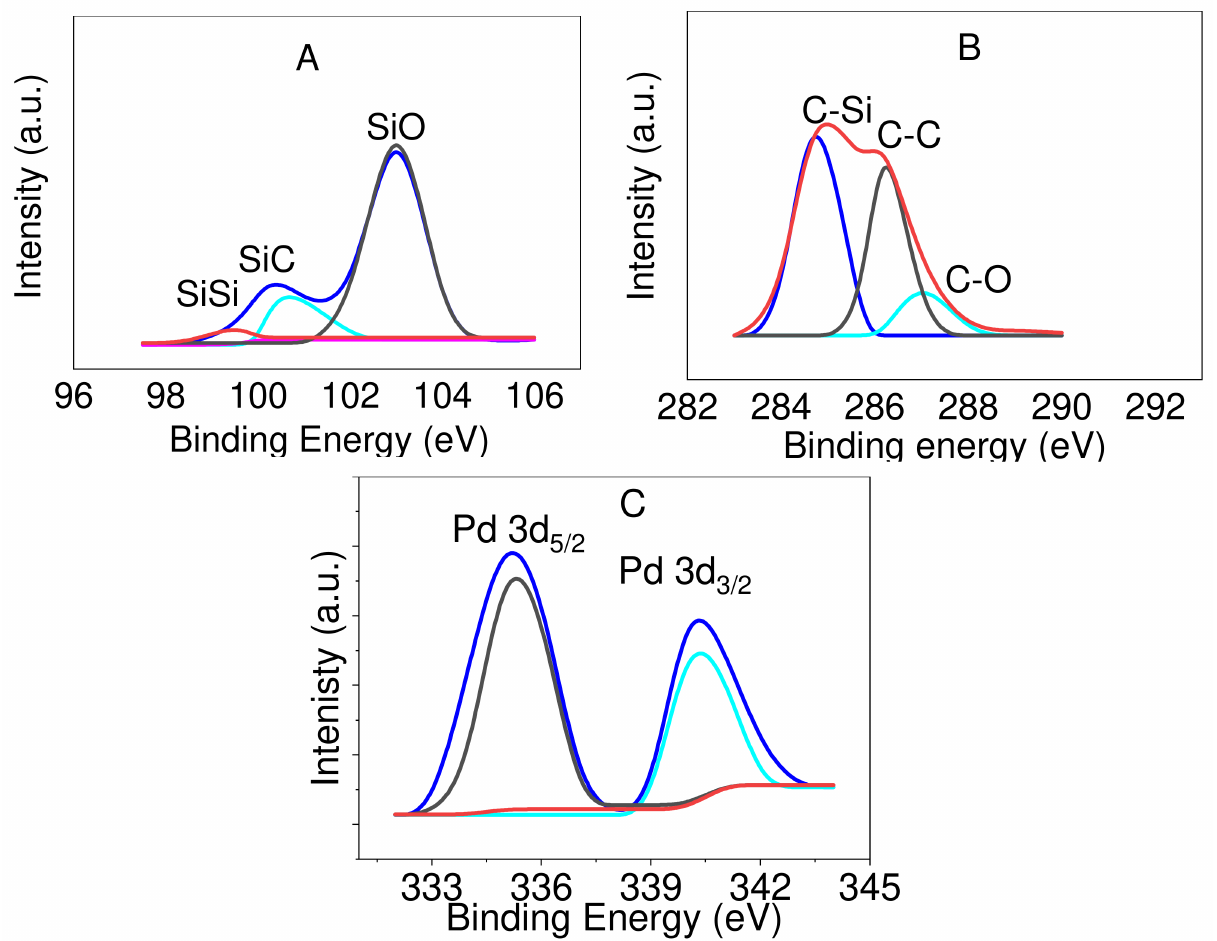
Figure 5. Deconvoluted XPS spectra of Pd@C–PS for the peaks ascribed to Si ( A ), C ( B ), and Pd ( C